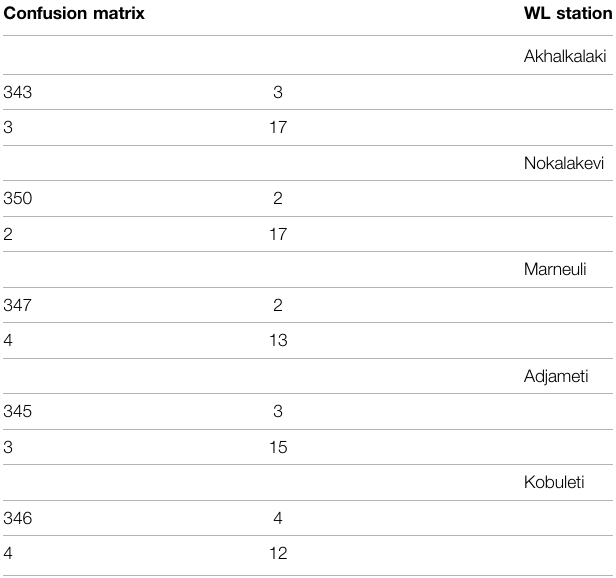
TABLE2| FinalconfusionmatrixescalculatedontheoriginalEQdataoffourtarget stations using the remaining four stations as the training set. Confusion